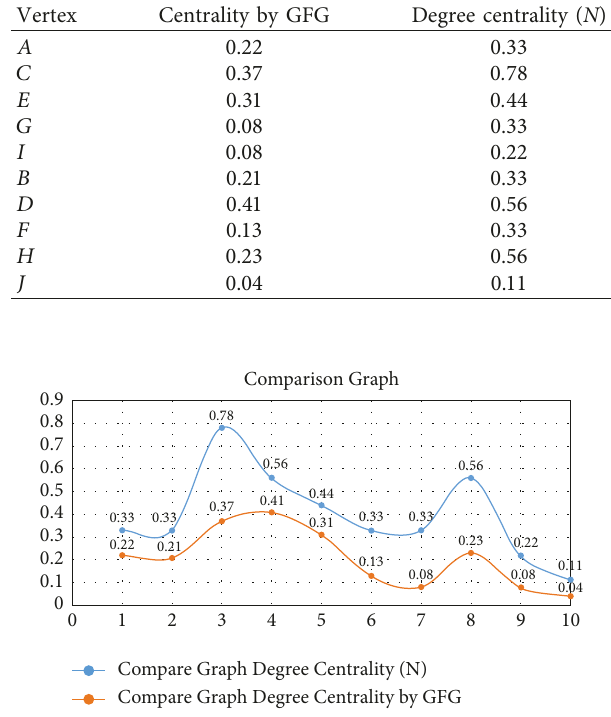
Table 8: Comparison of degree centrality ( N ) and centrality by GFG of all vertices of Figure 2. Vertex Centrality by